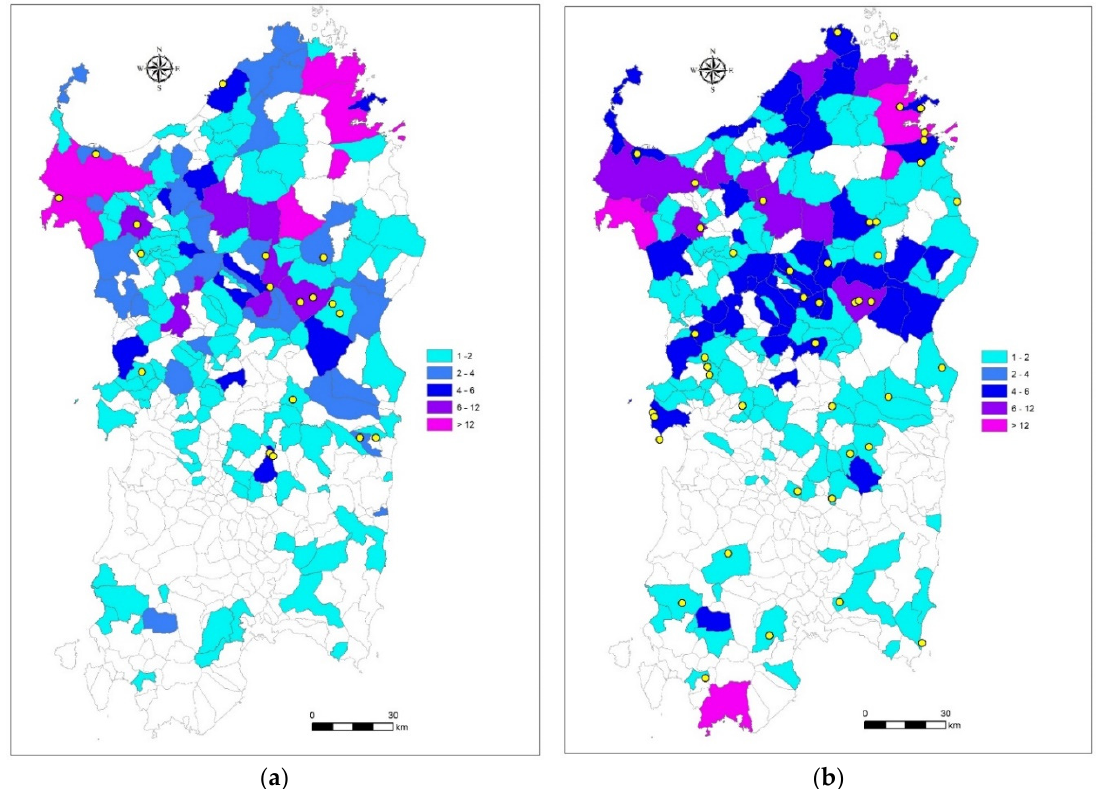
Figure 3. Geographical distributions of the samples taken and tested distinguished by found dead animals (carcasses) and road kills in 2020 ( a ) and 2021 ( b ). Gradient of color indicates the overall number of wild boar killed by road traffic in each common. Yellow dots indicate the places of each carcass findings.